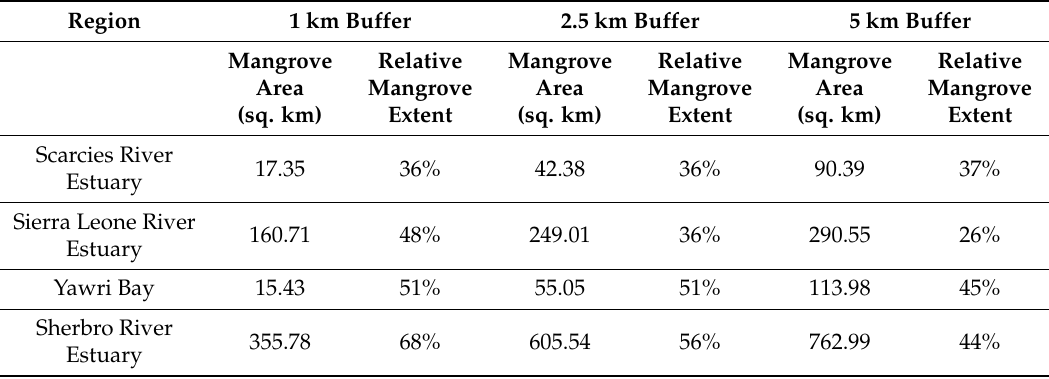
Figure 4. ( a ) Spatial distribution of the four land cover classes across the Sierra Leone coastal landscape complex for 2016. Panels show mangrove extents in ( b ) northern Sierra Leone (Scarcies River Estuary and Sierra Leone River Estuary) and ( c ) southern Sierra Leone (Yawri Bay and Sherbro River Estuary). Table 4. Estimated mangrove cover in 2016 within different buffers for the four focus areas in Sierra Leone.